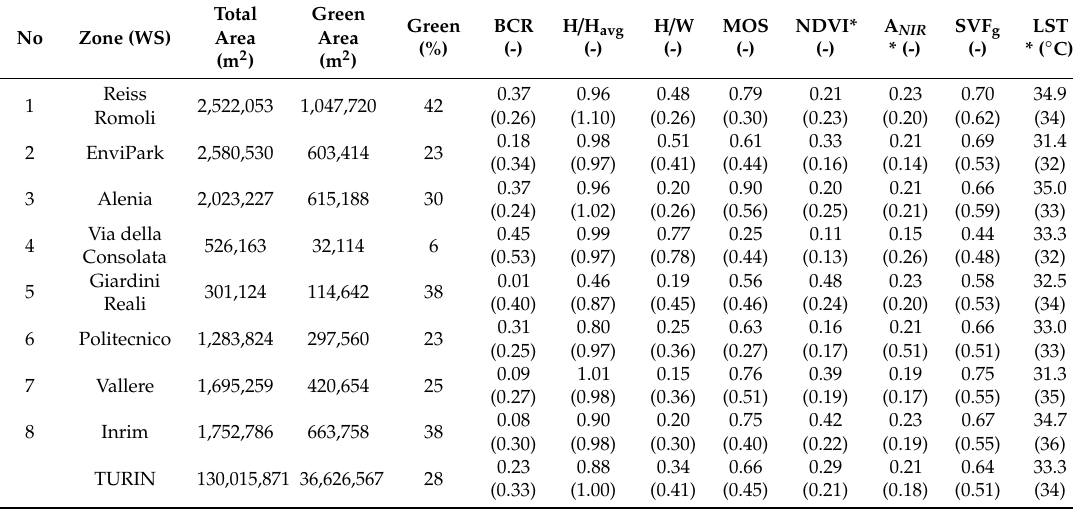
Figure 13. Analysis of the vegetation in the Politecnico area at a district scale: correlation between the percentage of green areas using the FA results and the NDVI values obtained using Landsat 8 image (25 August 2016). Table 8. Vegetation analysis conducted with the FA tool: percentage of green areas according to the RGB and IR orthophotos and urban variables values at census section scale (* satellite images refer to August 25 th 2016, in brackets average value for the entire eight area).